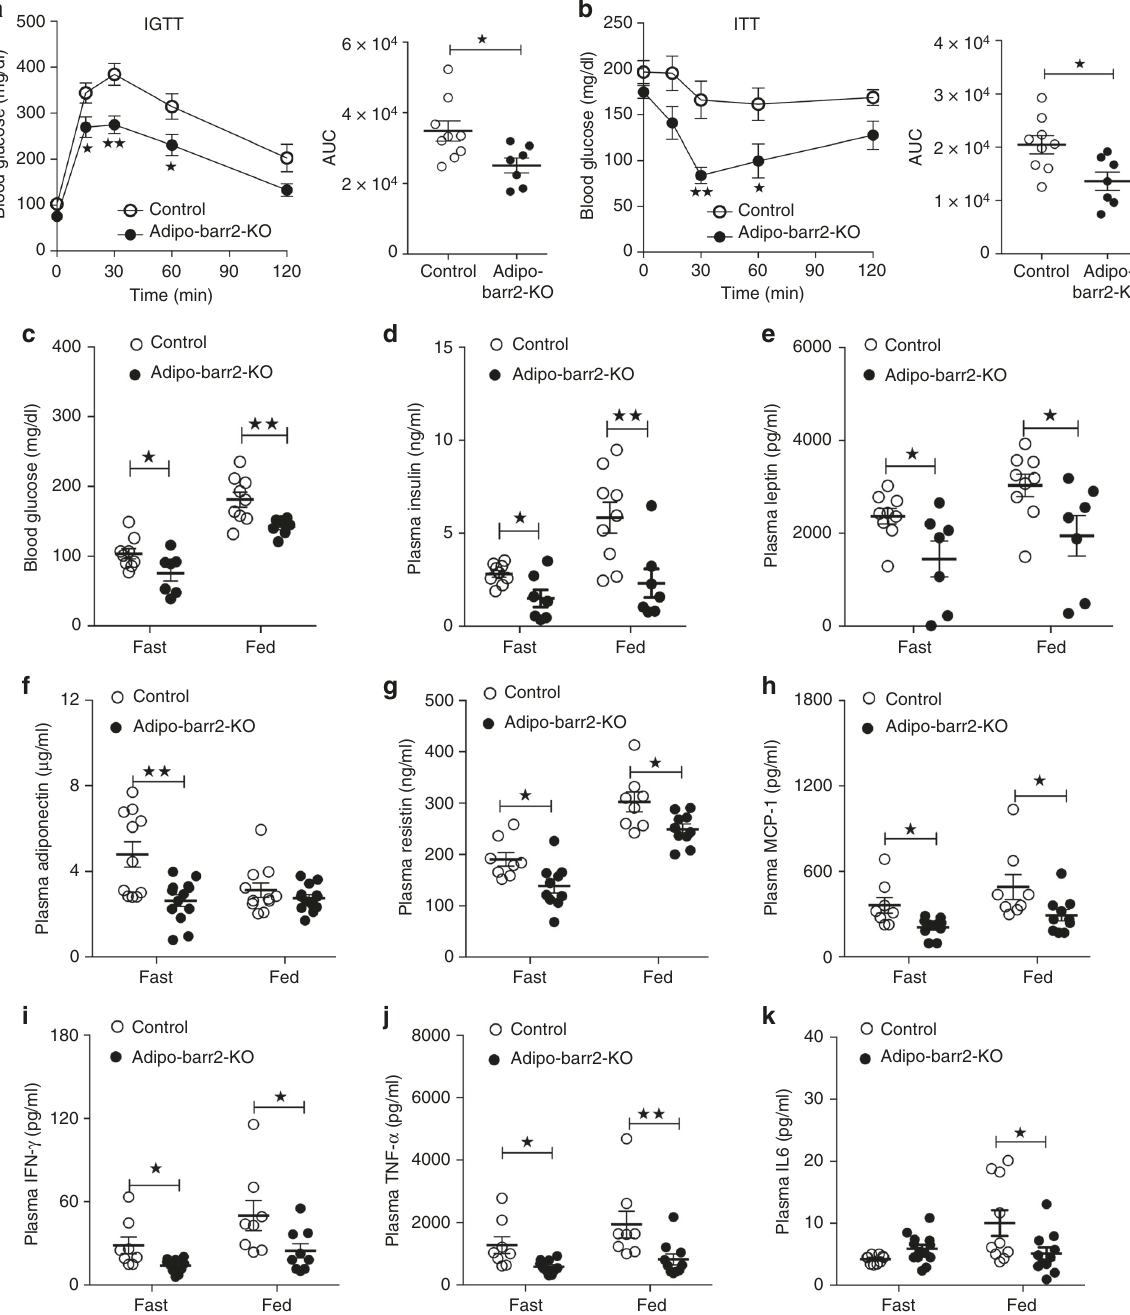
Fig. 2 Adipo-barr2-KO mice are protected against the detrimental metabolic effects caused by the consumption of a HFD. a , b In vivo metabolic tests. Control and adipo-barr2-KO mice maintained on HFD for 8 – 9 weeks were subjected to i.p. glucose tolerance (1 g glucose/kg; IGTT) ( a ) and insulin tolerance tests (1 U insulin/kg i.p.; ITT) ( b ) ( n = 7 – 9/group). AUC, area under the curve. c , d Freely fed and fasting blood glucose ( c ) and plasma insulin levels ( d ) of control and adipo-barr2-KO mice maintained on HFD for 8 – 9 weeks ( n = 7 – 9/group). e – g Freely fed and fasting plasma leptin ( e ), adiponectin ( f ), and resistin ( g ) levels in control and adipo-barr2-KO mice maintained on HFD for 12 weeks ( n = 7 – 10/group). h – k Plasma levels of proin fl ammatory cytokines. MCP-1 ( h ), IFN- γ ( i ), TNF- α ( j ), and IL6 ( k ) plasma levels in control and adipo-barr2-KO mice fed with HFD for 12 weeks ( n = 8 – 11/group). All experiments were carried out with male mice. Data are given as means± s.e.m. * p < 0.05, ** p < 0.01 ( a , b two-way ANOVA followed by Bonferroni ’ s post hoc test or two-tailed Student ’ s t -test (AUC); c – k two-tailed Student ’ s t